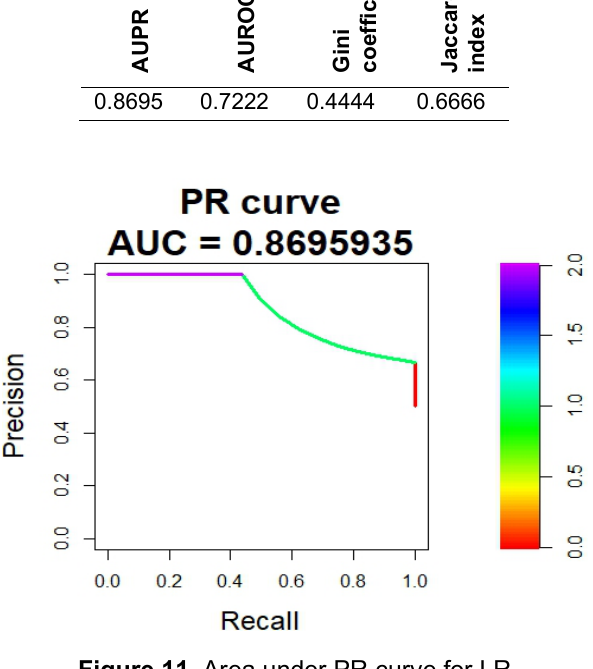
Figure 11. Area under PR curve for LR